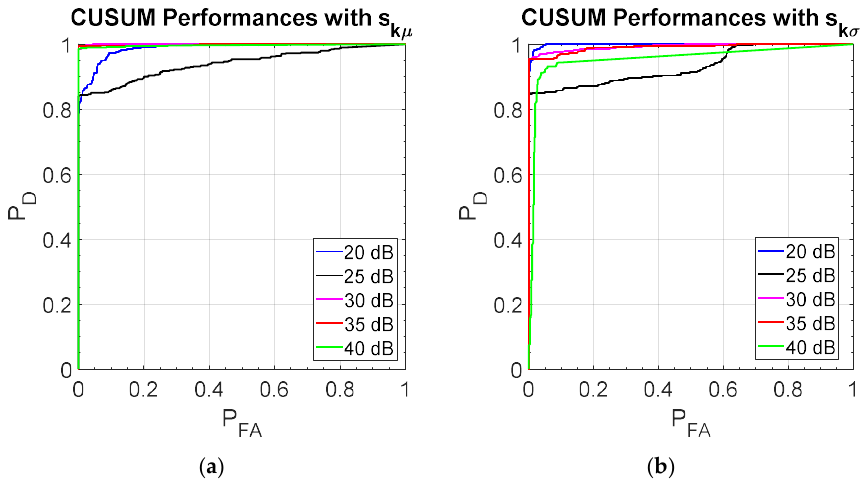
Figure 13. 100 µ s OSF detection performance for 20 rad / s and 50% of the load: ( a ) With mean value, Figure 13. 100 µs OSF detection performance for 20 rad/s and 50% of the load: ( a ) With mean value, ( b ) ( b ) With variance. Energies 2019 , 12 , x FOR PEER REVIEW With variance.